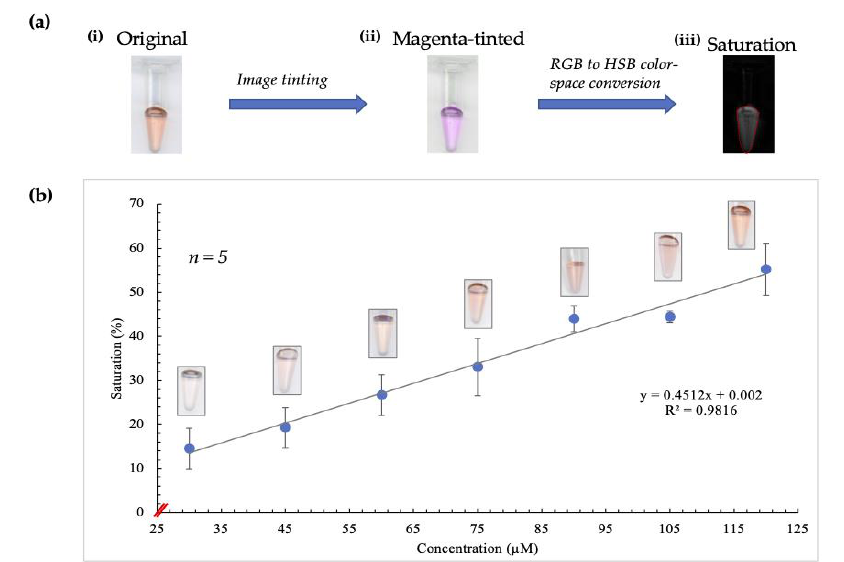
Figure 2. Illustration of results obtained using image-tinting techniques. ( a ) ( i ) shows a scanned image of a tube containing the complex formed after the Sakaguchi reaction was performed on a standard sample. The intensity of red color correlates directly to increasing arginine concentration. ( ii ) shows the image following red to magenta conversion in Fiji. Saturation (image shown in ( iii )) was obtained using RGB (red, blue, green) to HSB (hue, saturation, brightness) color-space conversion, resulting in the observation of a more linear relationship between saturation and concentration. ( b ) shows the curve obtained when concentration was correlated with saturation values following image-tinting. The corresponding images obtained for each concentration are also depicted on this curve.